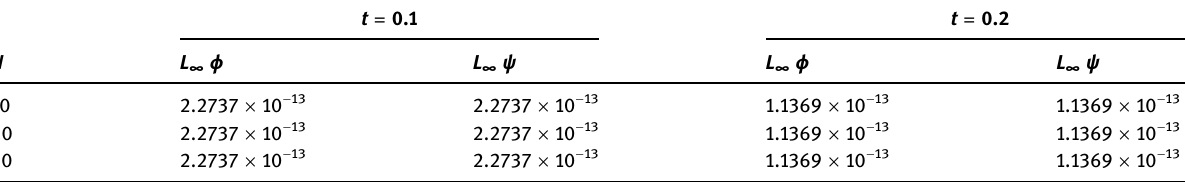
Table 10: L ∞ errors of ϕ and ψ components at di ff erent grid points regarding Example 4 t =